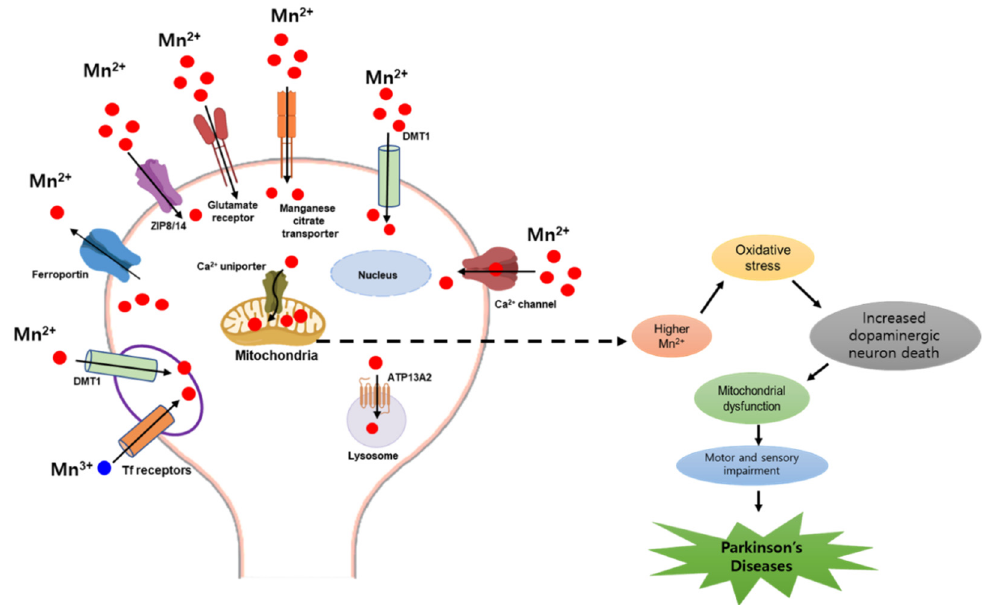
Figure 2. Receptors and channels involved in Mn homeostasis. Various cellular receptors, such as divalent metal transporter 1 (DMT1) and transferrin receptor (TfR), as well as Ca 2+ channels, ZIP8/14 transporter, and Mn citrate transporter facilitate the entry of divalent Mn into cells, whereas ferroportin and Ca 2+ facilitate its expulsion from cells and mitochondria, respectively. Mn 2+ is pas- sively transported via glutamate-activated ion channels, while Mn 3+ entry is facilitated by transferrin. All of these mechanisms enhance the trafficking of Mn 2+ across the cells, leading to mitochondrial dysfunction and increased dopaminergic neuronal death, resulting in